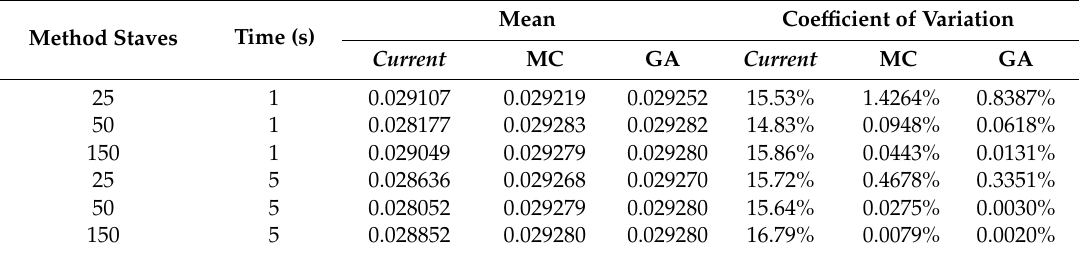
Table 2. Results of the construction of 100 heads with a target OTR of 0.02928 hPa / h. The parameter “method staves” refers to the number of staves that are considered in the method dataset (Figure 6), and the time refers to the number of seconds that the methods iterate prior to outputting the best solution that has been found during this time.